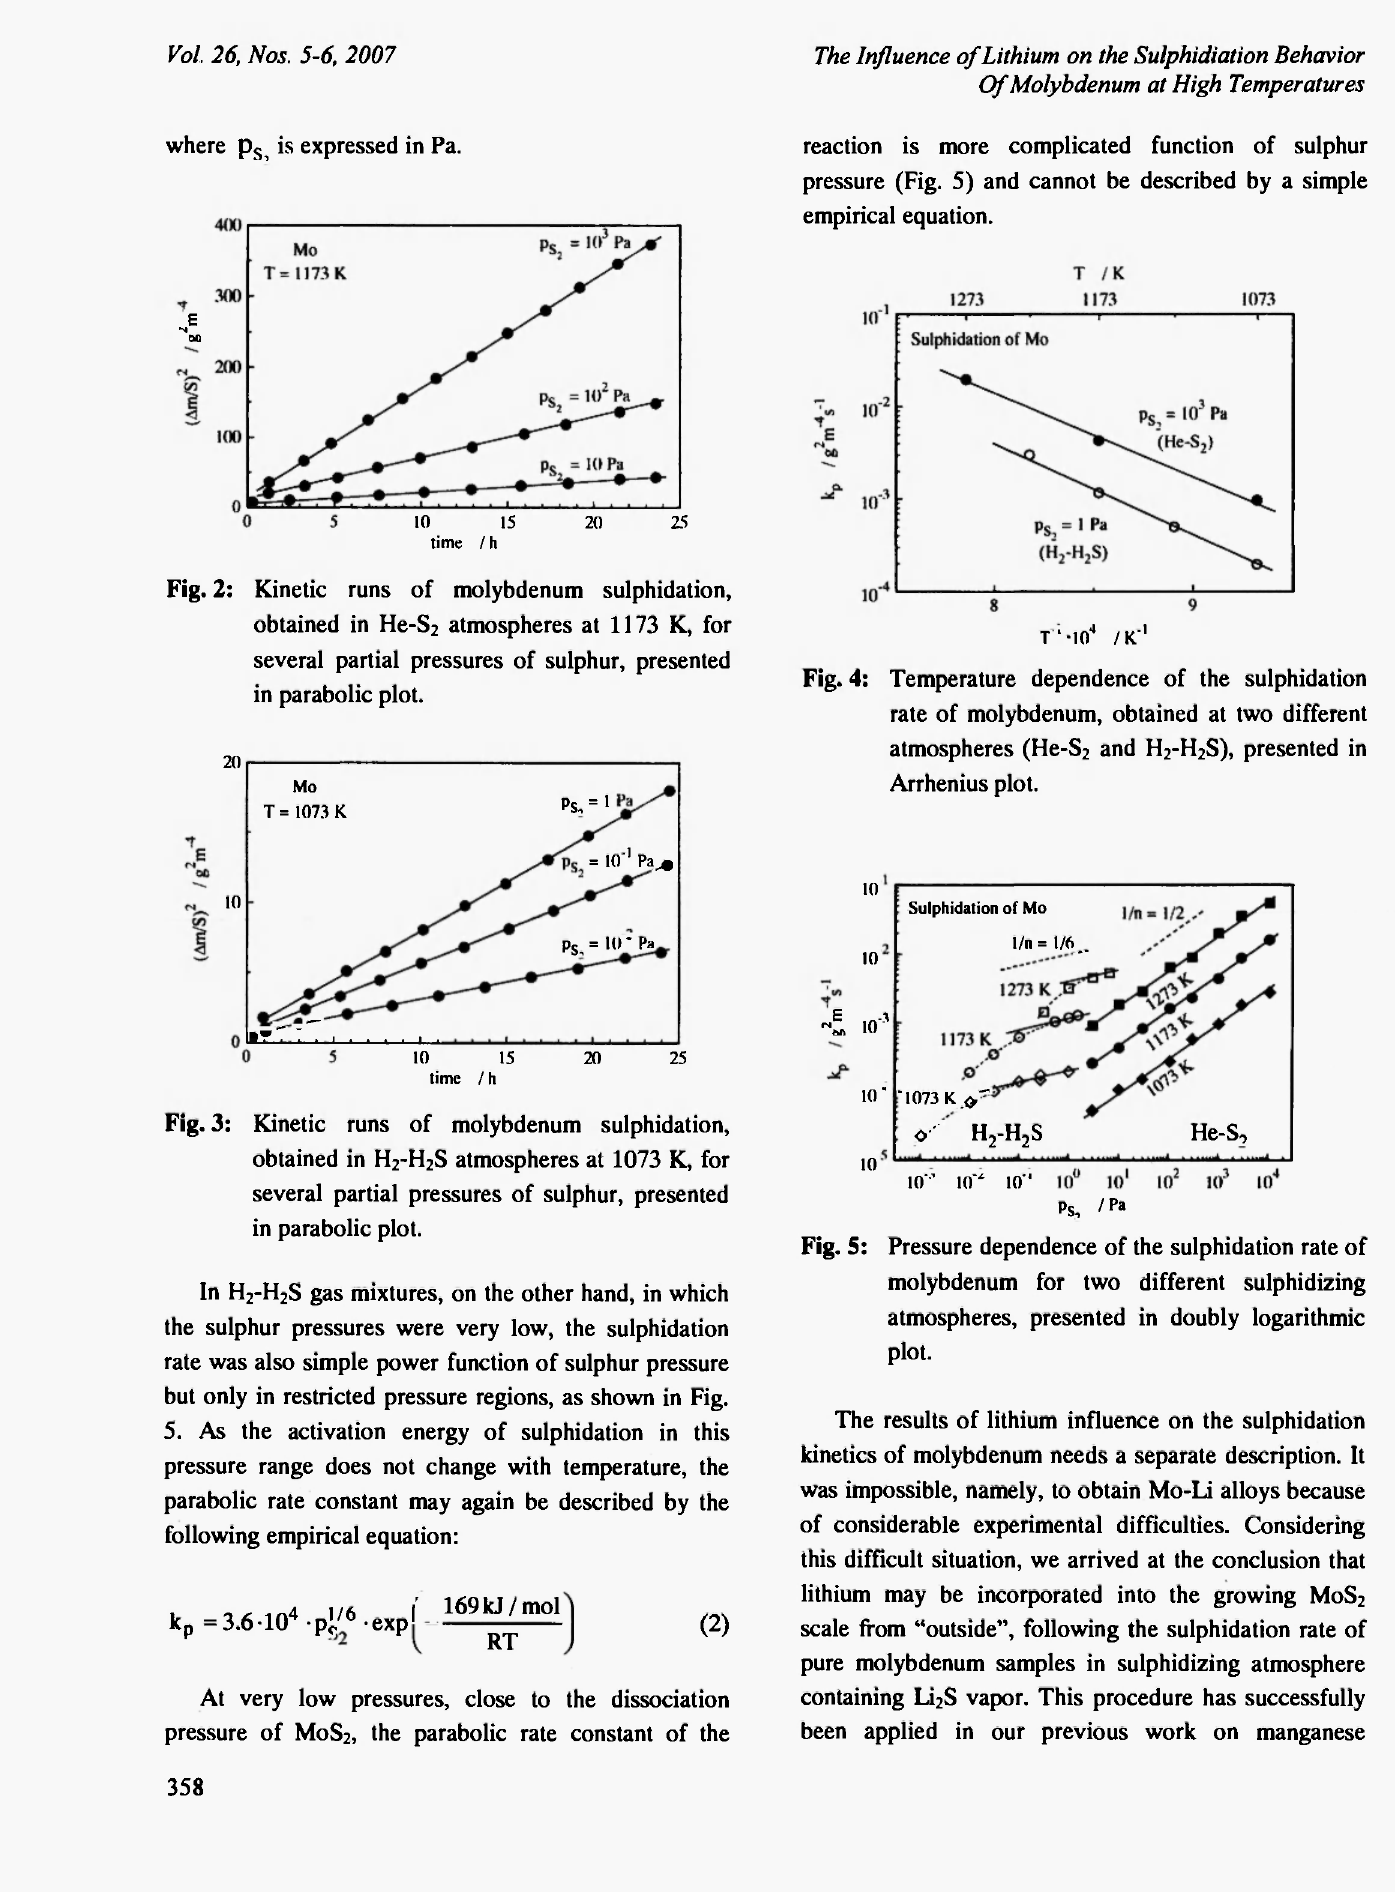
Fig. 2: Kinetic runs of molybdenum sulphidation, obtained in He-S 2 atmospheres at 1173 K, for several partial pressures of sulphur, presented in parabolic plot.